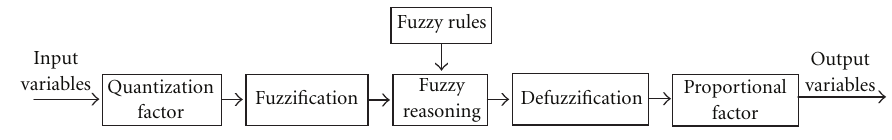
Figure 3: Basic structure of fuzzy model.